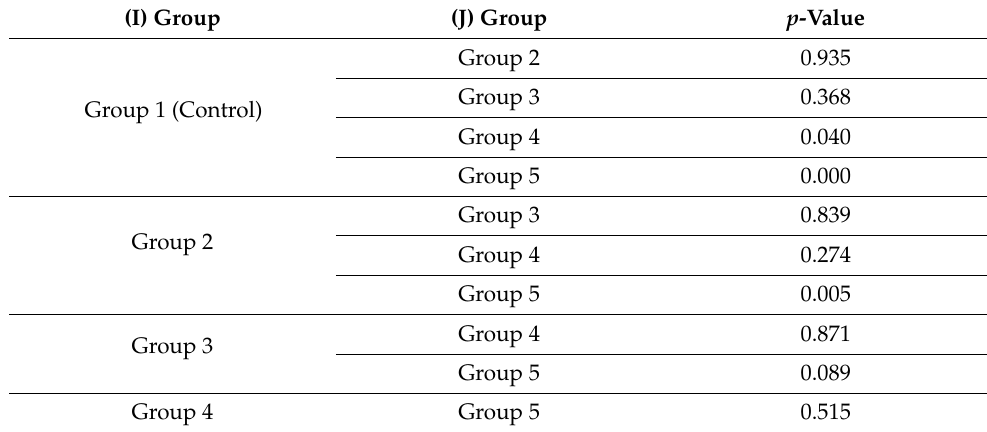
Table 4. Post hoc Tukey’s multiple comparison test between groups for compressive strength.